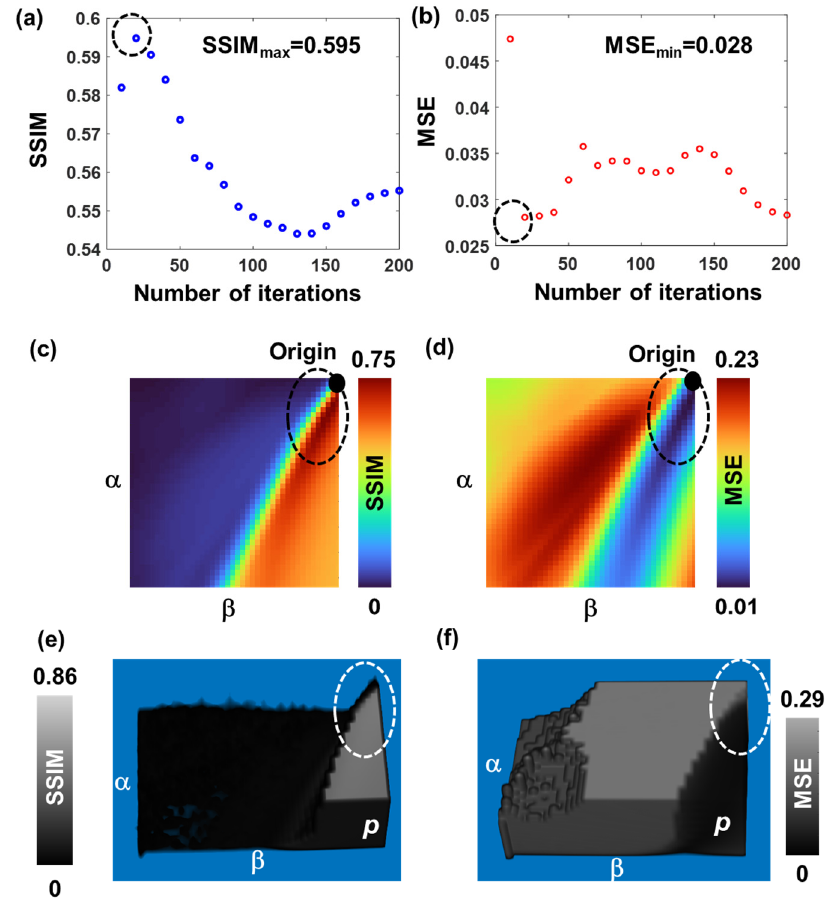
Figure 6. Comparison of SSIM ( a ) LRA, ( c ) NLR and ( e ) LR 2 A and MSE for ( b ) LRA, ( d ) NLR and ( f ) LR 2 A for spectral aberration with ∆ λ = 232.8 nm corresponding to first column of Figure 5. The number of iterations is p . The dotted circles indicate the regions of highest SSIM and lowest MSE.